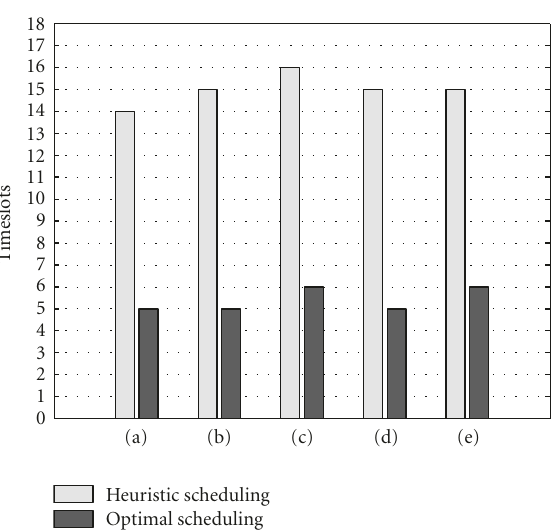
Figure 6: Comparison between packing heuristic and optimal scheduling for the di ff erent routing schemes for the case of 18 nodes: (a) interference aware pruning routing (IAPR), (b) minimum power routing (MPR), (c) minimum neighbors-based routing (MNR), (d) interference routing (IR), and (e) weighted power and interference routing (WPIR).